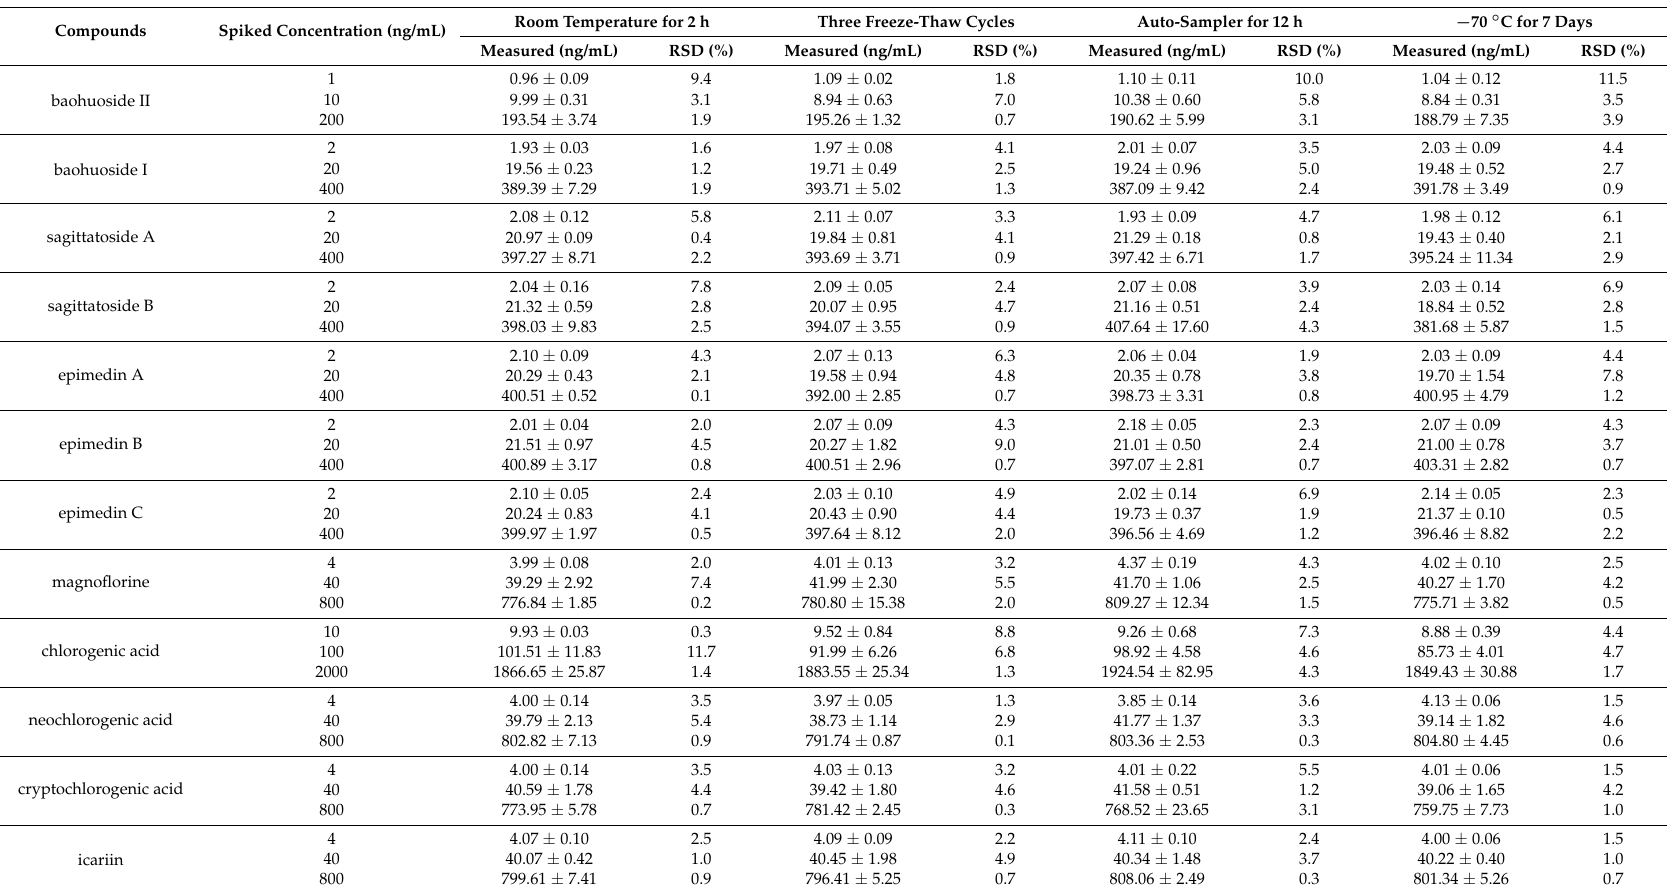
Table 4. Stability of all analytes in rat plasma ( n =